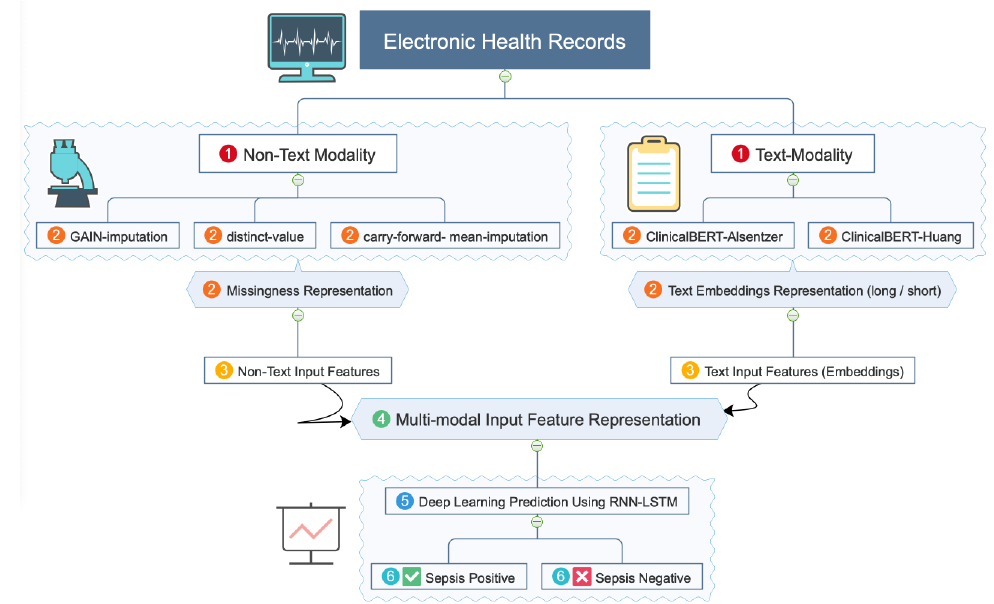
Figure 5. Schematic diagram of the proposed model for the single-server setting. For details please see Section